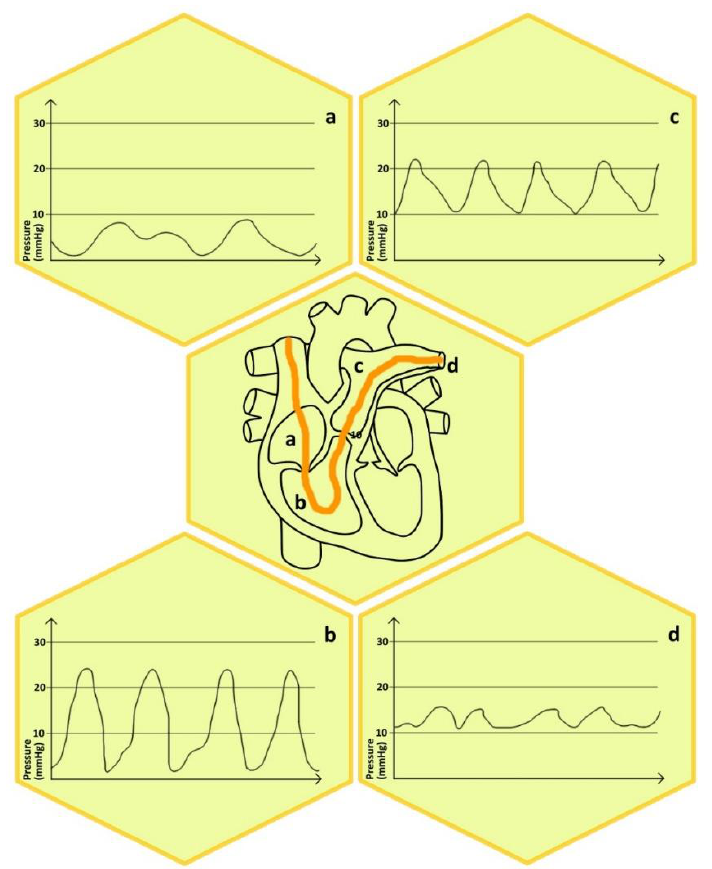
Figure 2. Typical pressure curves and values assessed during RHC within the physiological states. ( a ) right atrium, ( b ) right ventricle, ( c ) pulmonary artery, ( d ) tip of the catheter in a small artery.